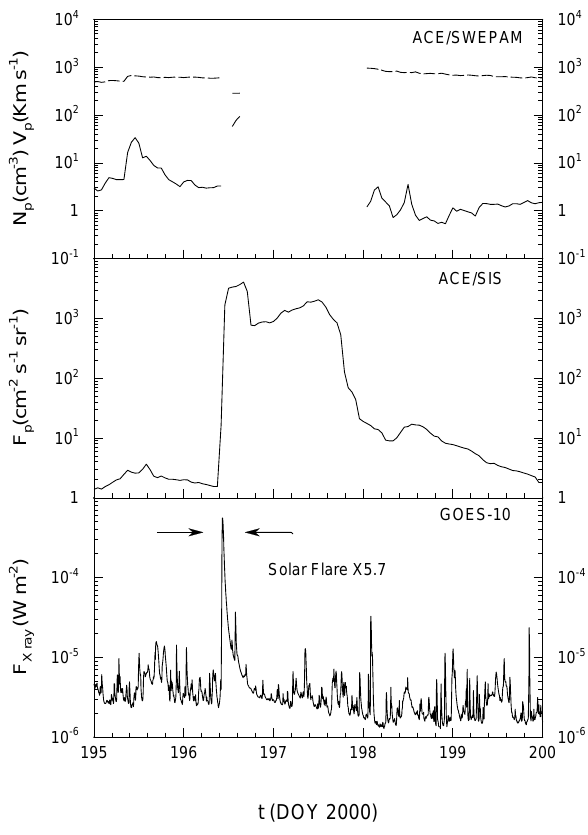
Fig. 1. Upper panel: ACE/SWEPAM proton density (solid line) and bulk speed (dashed line) hourly averages. Middle panel: ACE/SIS integral proton flux ( E> 10MeV) hourly averages. Lower panel: GOES-10 X ray flux five-minute averages (1 . 0 <λ< 8 . 0 ˚A wave- length